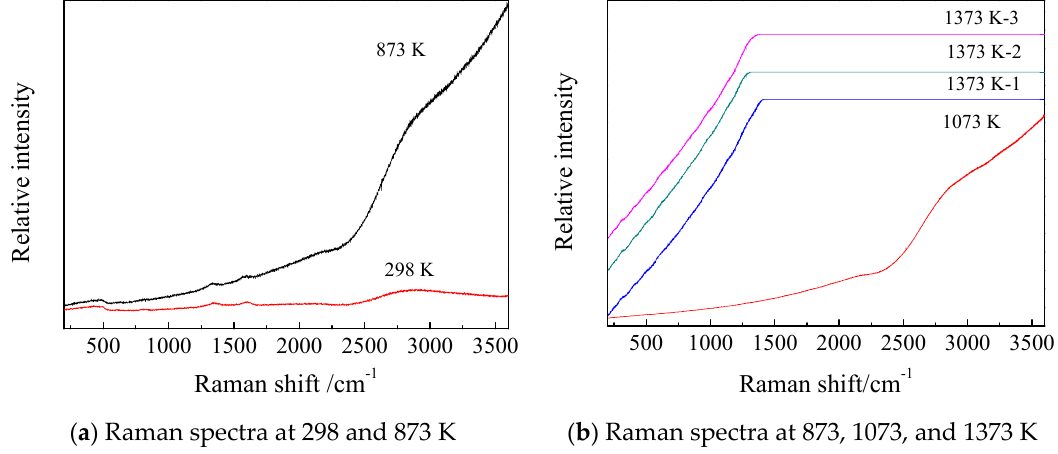
Figure 1. In-situ Raman spectra of coal samples in Ar atmosphere by using a 532 nm excitation laser.